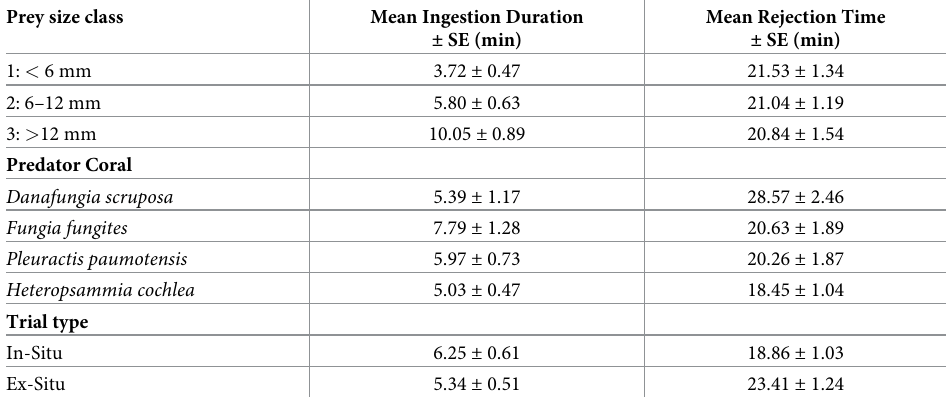
Table 3. Comparison of ingestion duration and time to rejection between three size classes of prey, four species of coral predator and between in-situ and ex-situ feeding trials.